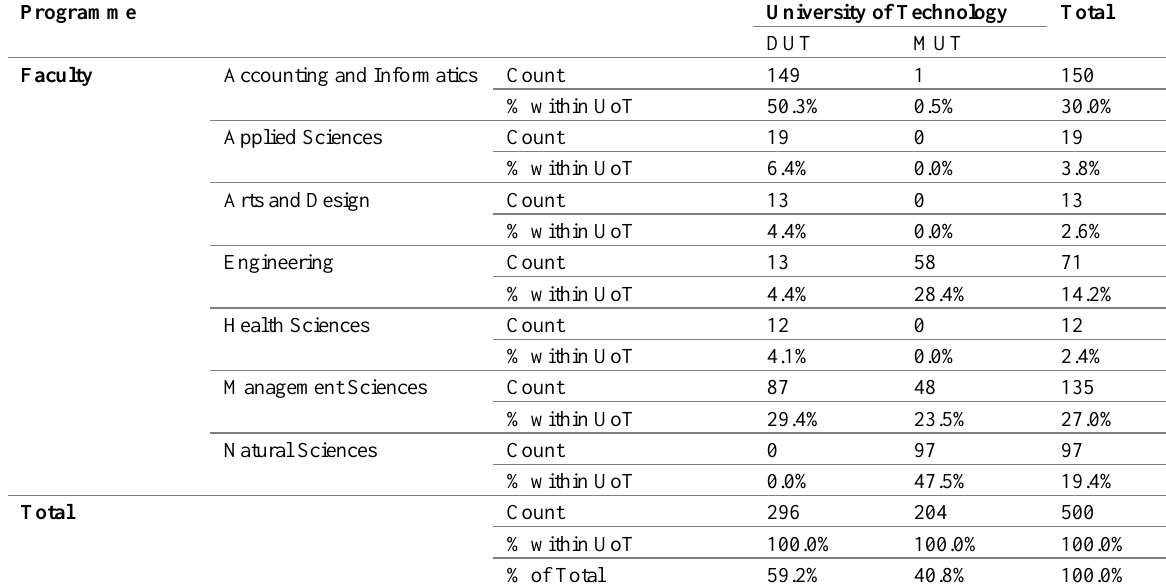
Table 5: Respondents’ faculty of study by